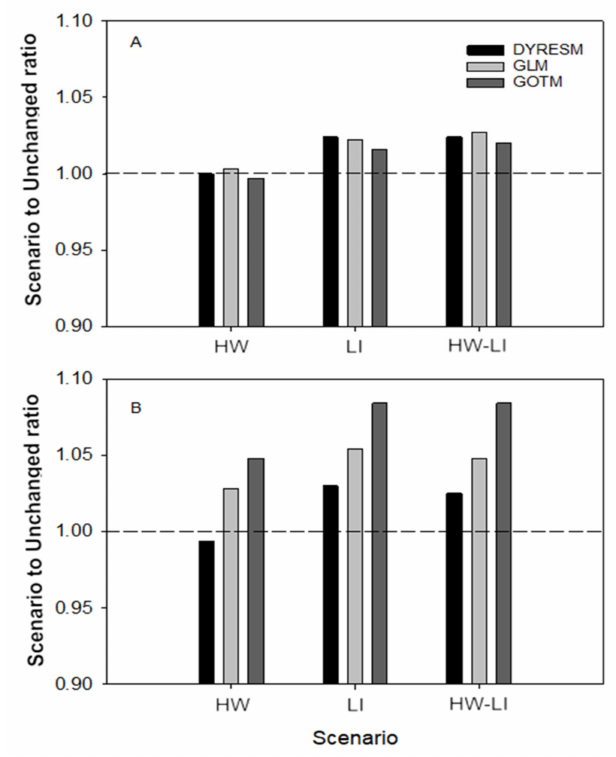
Figure 7. The ratio between the mean water temperature in each scenario in relation to the Unchanged scenario. The mean was calculated for the period 2015–2039 and for the 0–10 m layer ( A ) and 30–40 m layer ( B